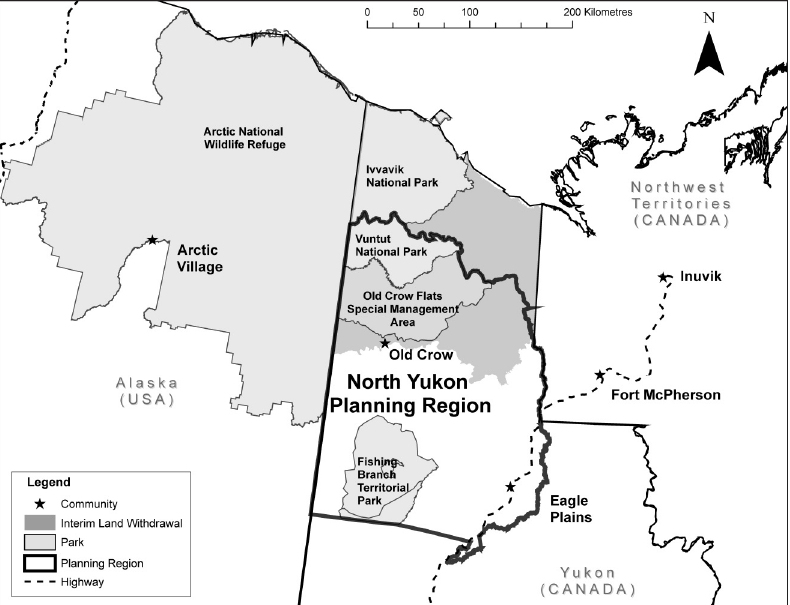
Fig. 1. Location of the North Yukon Planning Region (thick black outline) in northern Yukon Territory, Canada. Protected areas within the region include Vuntut National Park and Fishing Branch Territorial Park. A pro- tected land designation for the Old Crow Flats Special Management Area (SMA) is in progress (March 2007). An additional protected area under interim land withdrawal is also